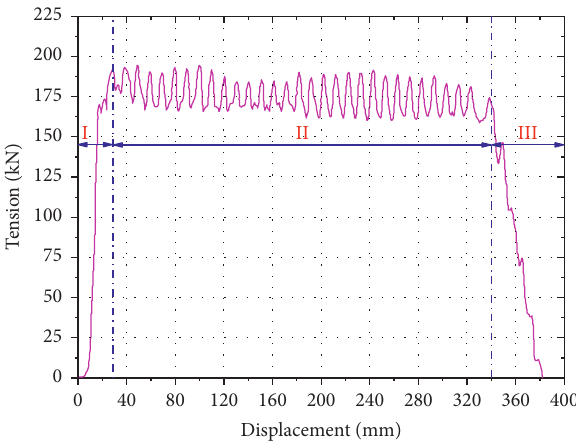
Figure 12: The force and displacement curve of